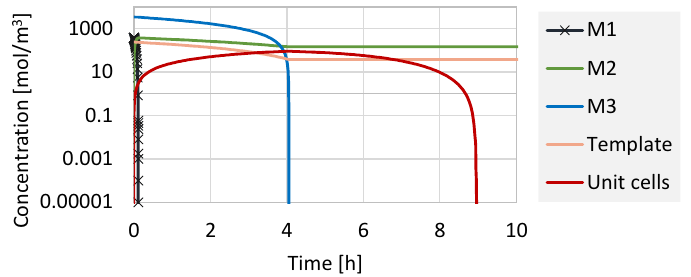
Figure 9. Change in the molar concentration of all materials during the synthesis